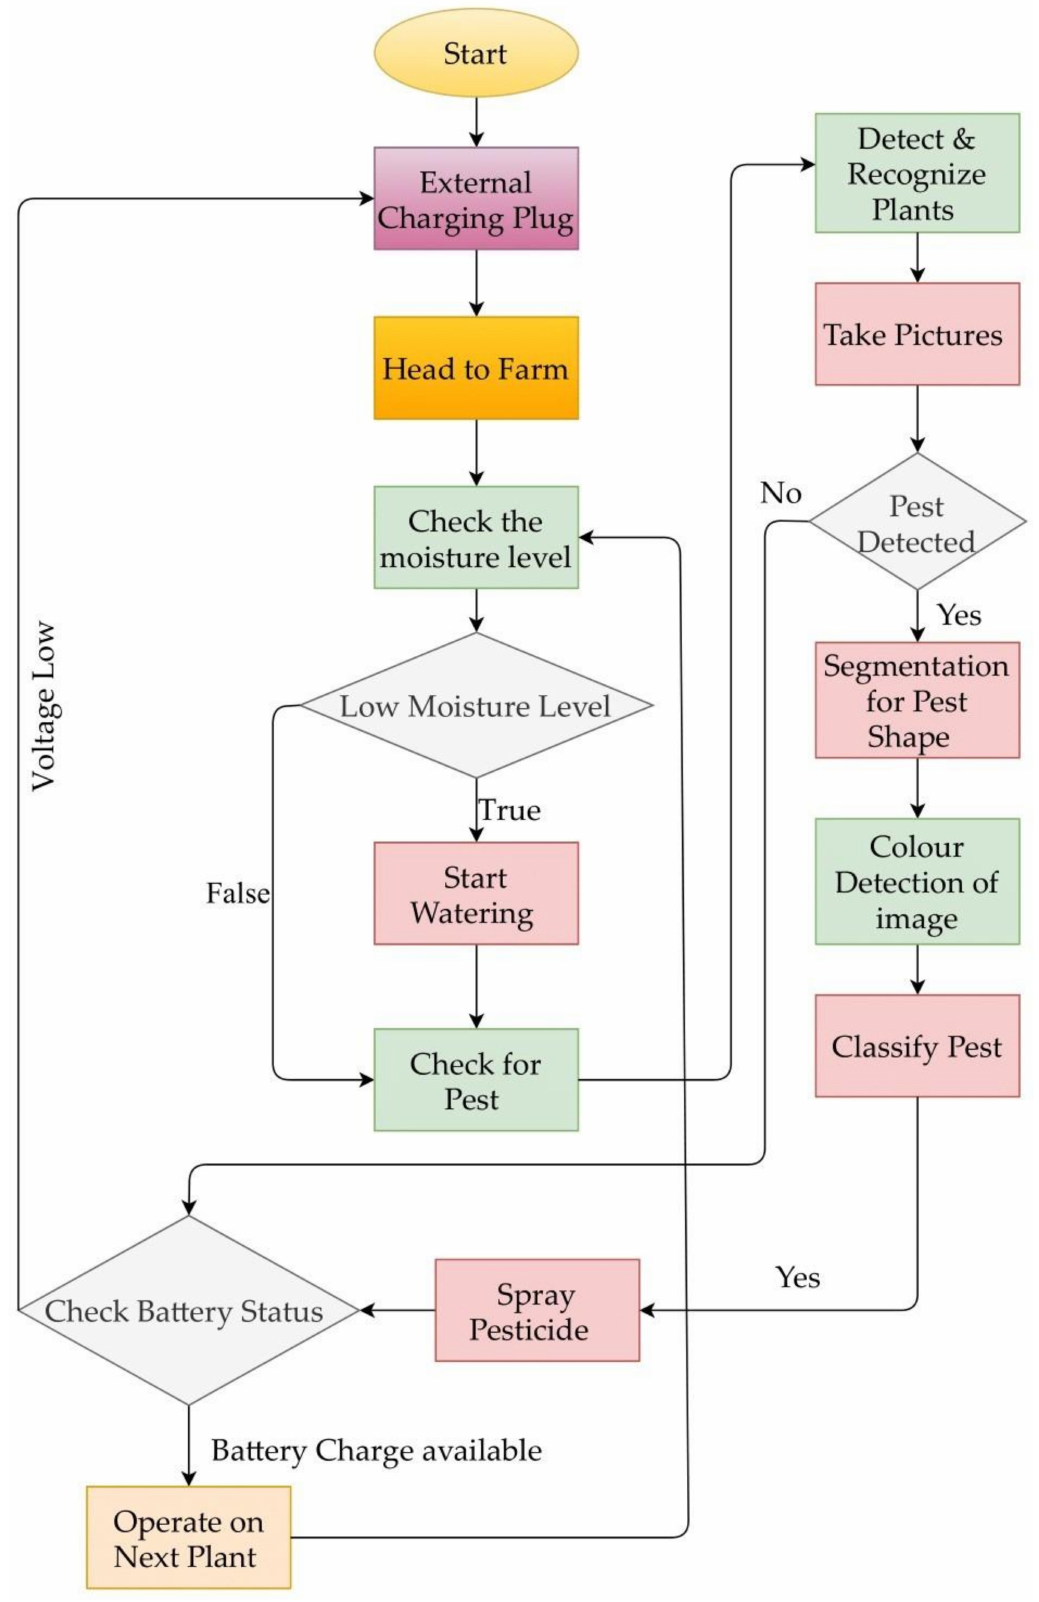
Figure 8. Flow chart showing the water sprinkling and pesticide spraying mechanism based on the soil moisture measure- ment and image